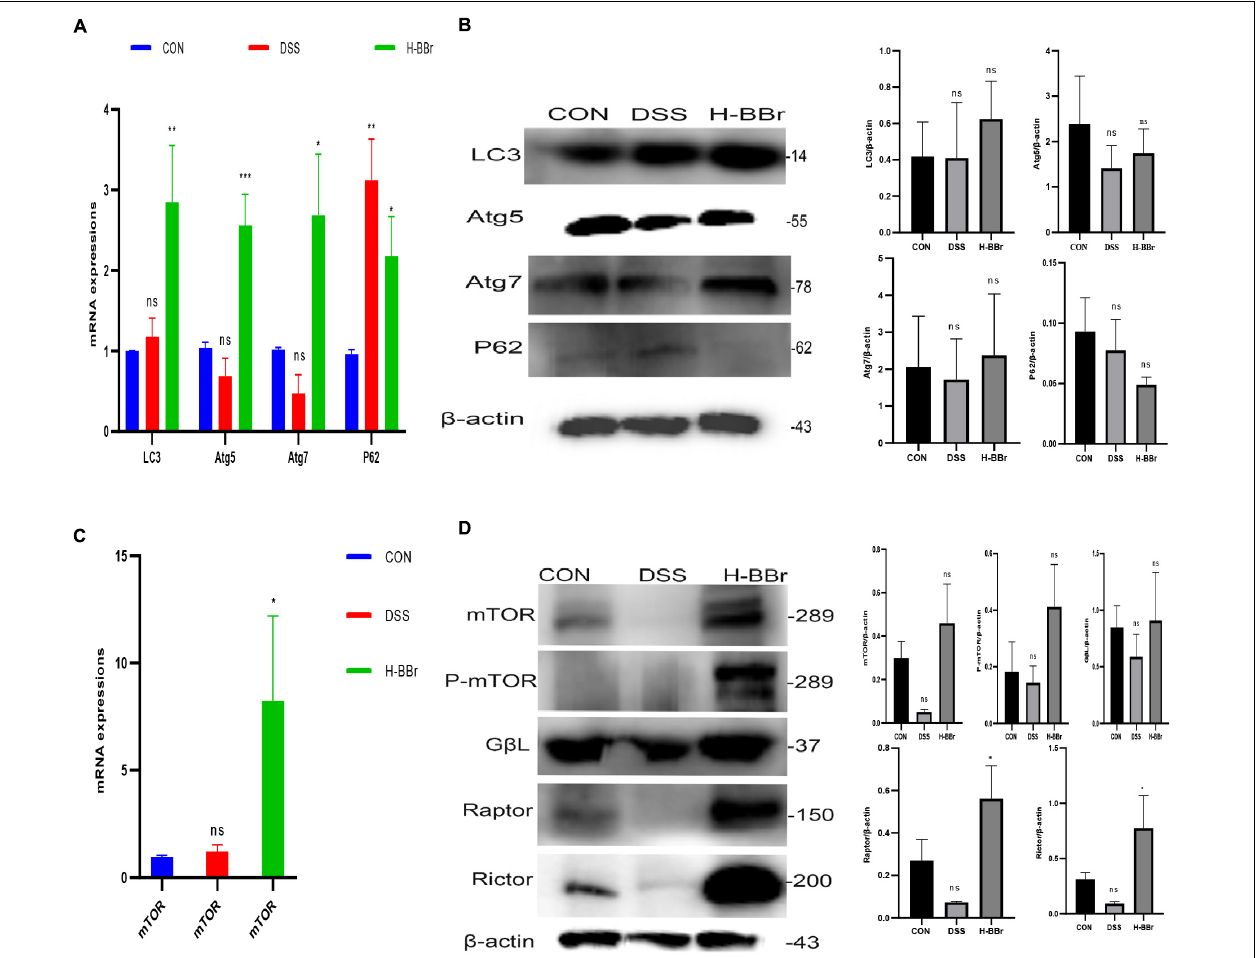
FIGURE 7 | BBr-activated autophagy and MTORC are essential to cure colitis. mRNA (A) and Proteins (B) expressions of LC3, Atg5, Atg7, and P62. mRNA (C) and Proteins (D) expressions of MTORC (mTOR, Rictor, Raptor, and G β L) and P-mTOR. Data represent the mean ± SD . P < 0.05 was considered statistically significant. * P < 0.05, ** P < 0.01, and *** P < 0.001 vs CON